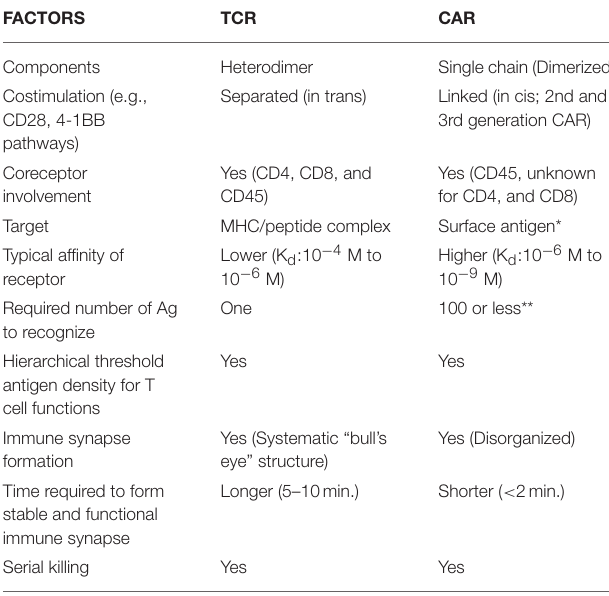
TABLE 1 | Comparison of CAR and TCR T cell biological